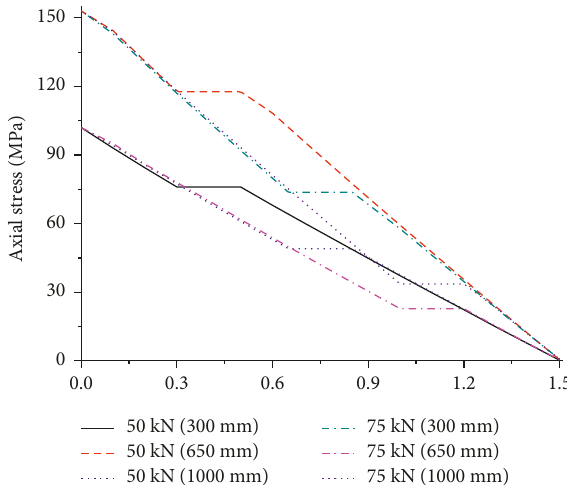
Figure 11: The axial stress distribution along the rock bolt under pullout loads.